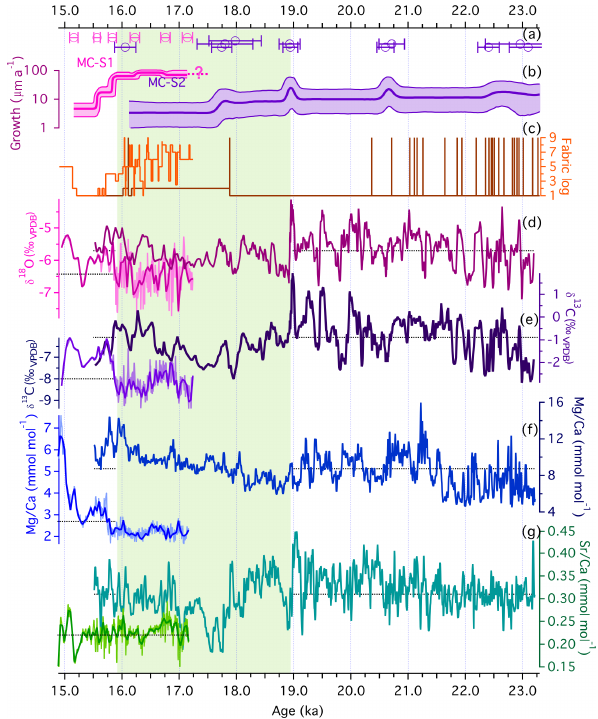
Figure 3. Mairs Cave stalagmites MC-S1 and MC-S2: age mea- surements (a) , growth rate (b) , fabric log (c) , δ 18 O (d) , δ 13 C (e) , Mg / Ca (f) , and Sr / Ca (g) . Note different offset scales on left and right-hand axes for panels (e) to (g) . Short-lived peaks in growth rate at 19 and 20.6ka are artefacts of closely spaced age measurements. Fabric log indicates calcite fabric classification, where values 1 to 8 indicate a scale, ranging as follows: closed columnar without lam- inations (1), columnar with faint laminations, parallel laminations and rhombohedral tips (2 to 4), open columnar calcite (5), and open columnar with faint laminations, parallel laminations and rhombo- hedral tips ( = 6 to 8); “9” marks re-nucleation episodes with geo- metric selection and possible dissolution. The hierarchy scale sug- gests increasing discharge and impurities content. Fine dotted line in panels (d) to (g) are mean values for each stalagmite. Pale green shading indicates an inferred relatively wetter